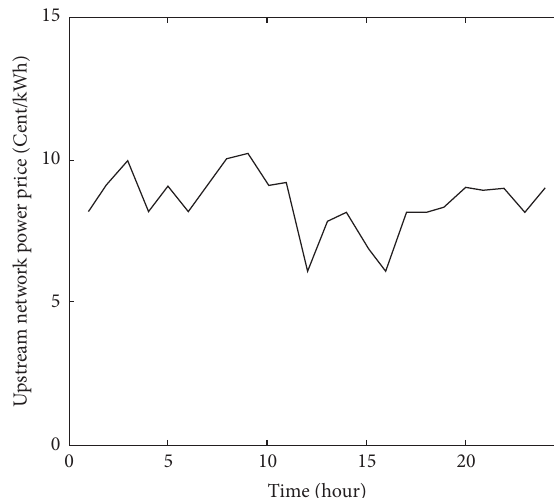
Figure 3: Termal demand of the energy hub system.